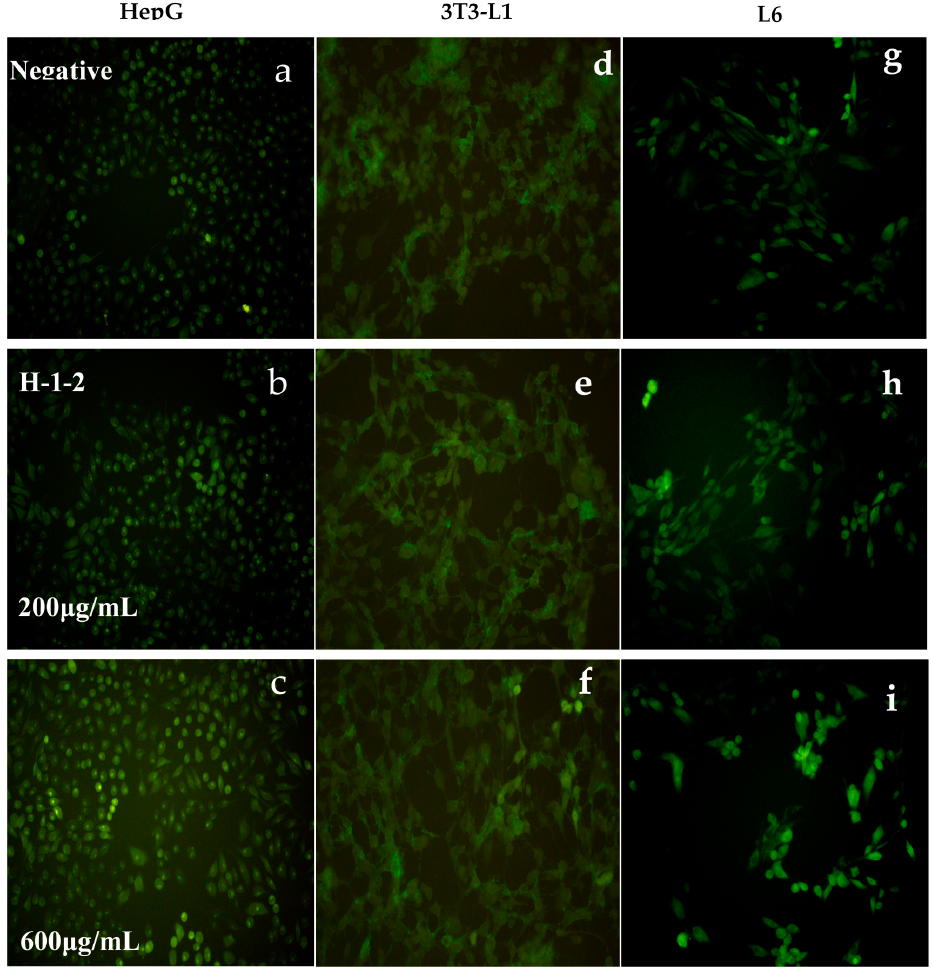
Figure 8. Fluorescence micrographs of 2-NBDG uptake into HepG2, 3T3-L1, and L6 cells